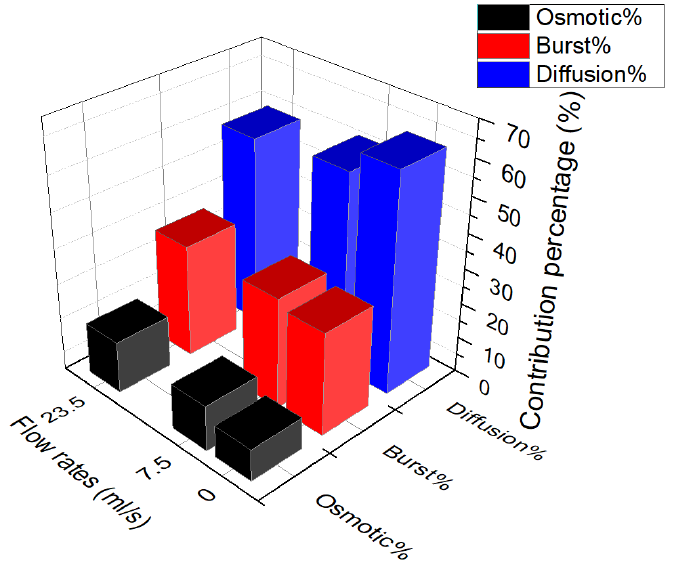
Figure 8. Percentage of the contribution of each mechanism during the drug release from PU films with 20% of the drug at the different flow rates of 0, 7.5 and 23.5 mL/s.